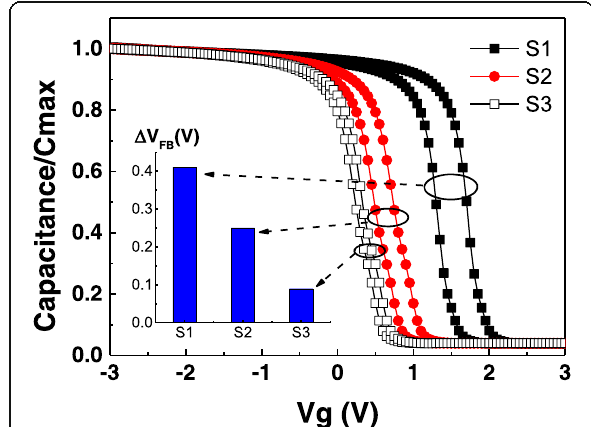
Fig. 2 C - V curves of samples S1 – S3. Δ V FB were extracted from C - V curves